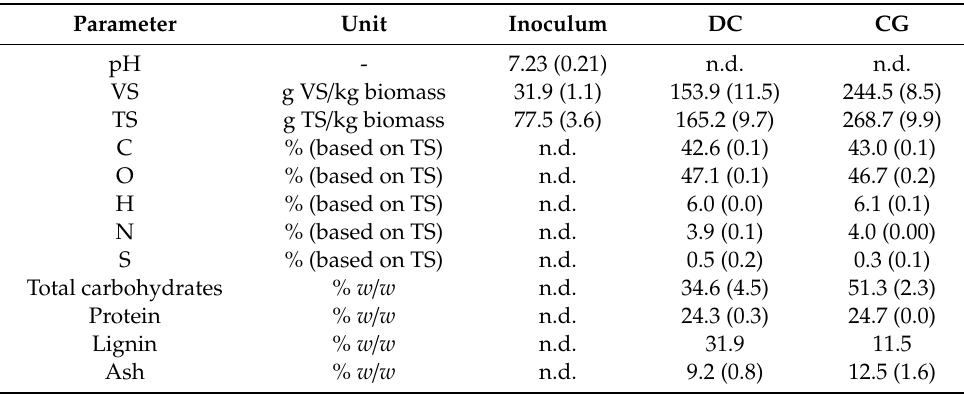
Table 1. Physico–chemical characteristics of the inoculum and substrates used in the batch tests. DC: ditch clippings; CG: canal